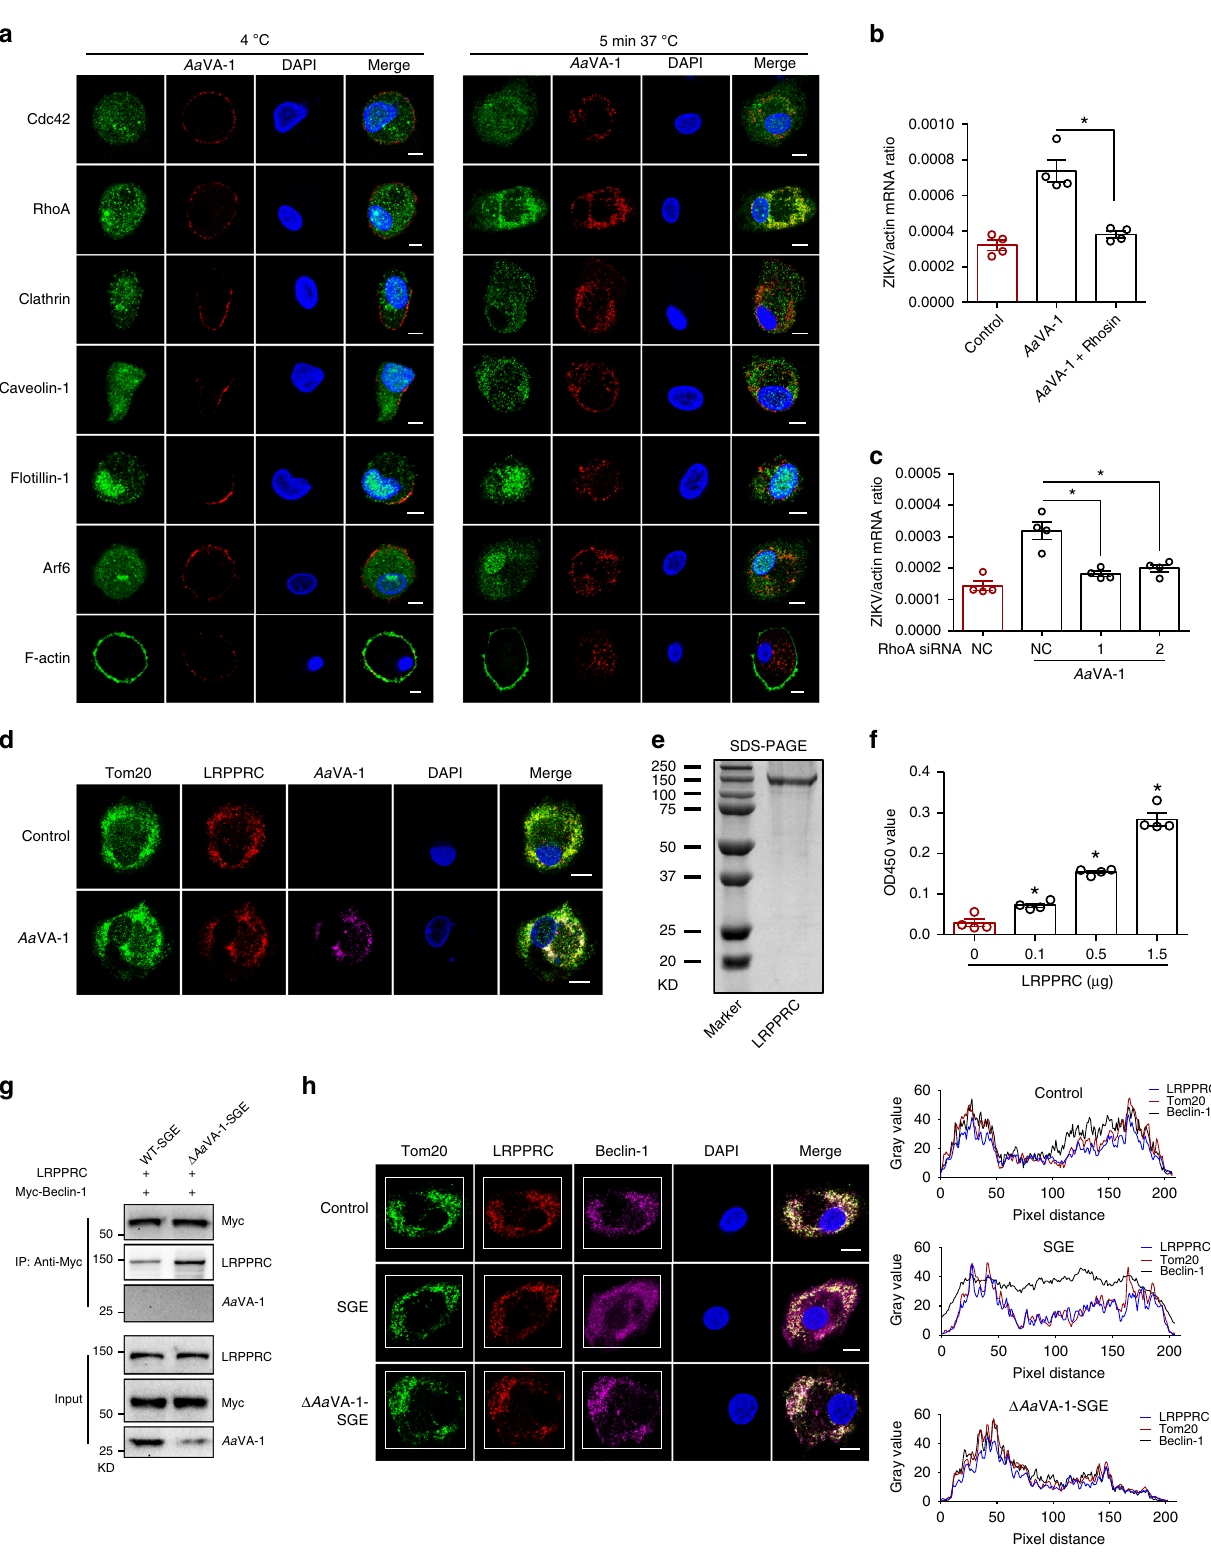
internalized 47 . Compared to the mock control, genetic suppres- sion of Beclin-1 did not in fl uence ZIKV attachment on the surface of THP-1 cells (Supplementary Fig. 15E). We next investigated the role of Beclin-1 in viral internalization. ZIKV was incubated with either the Beclin-1 -silenced THP-1 cells or the control